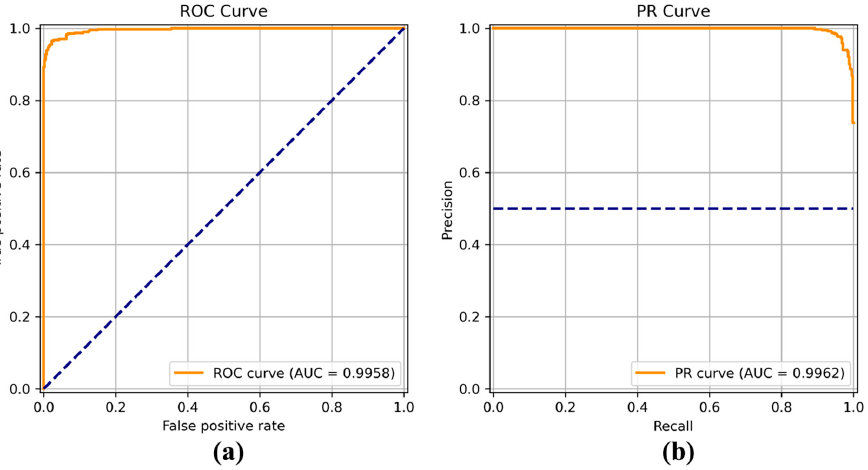
Figure 13. ( a ) Receiver operating characteristic (ROC) curve and ( b ) precision recall (PR) curve of ResNet.